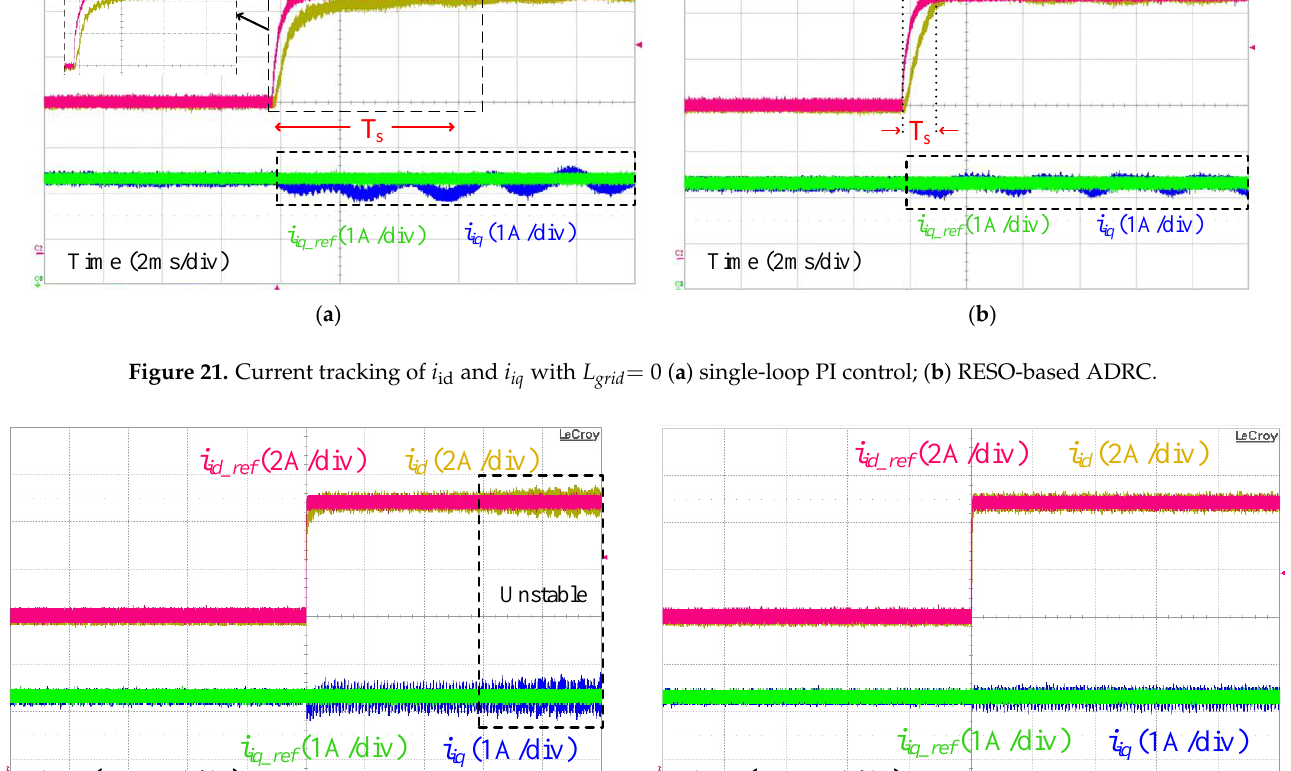
Figure 21. Current tracking of i id and i iq with L grid = 0 ( a ) single-loop PI control; ( b ) RESO-based ADRC.